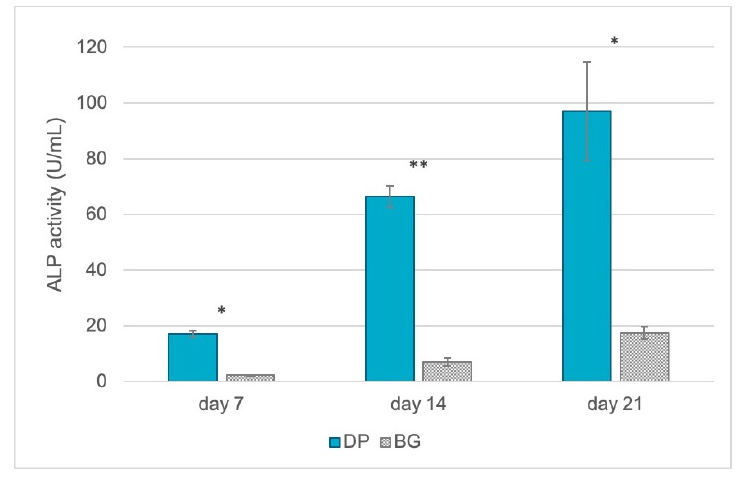
Figure 6. Quantification of intracellular ALP activity (expressed as U/mL) in DPSCs seeded for 7, 14, and 21 days onto DP (petrol blue bars) or BG (grey bars). The graph shows the mean ± SD of three different experiments. * p < 0.05, ** p < 0.01.